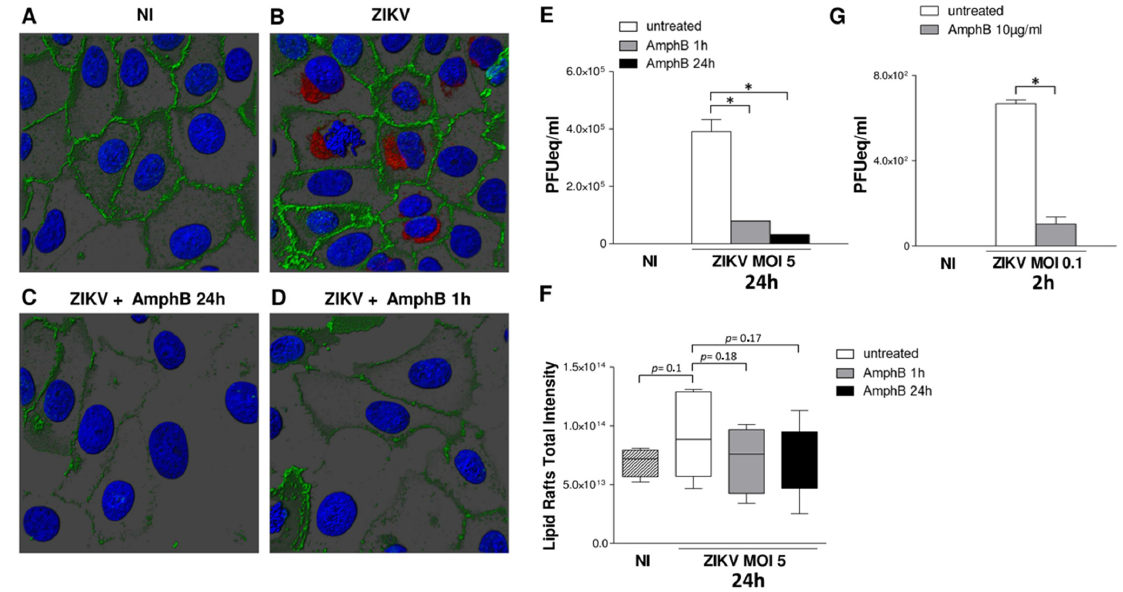
Figure 2. ZIKV exploits lipid rafts to enter and infect Vero cells. Vero cells were adsorbed with ZIKV at MOI 5 for 1 h at 37 °C in medium +/ − AmphB (10 µg/mL). Unbound virus was removed, and infected cells were cultured in fresh medium +/ − AmphB for 24 h or the drug was added only during 1 h of virus adsorption. At 24 h post-infection, cells were stained with the lipid raft marker CTB (green), fixed and stained with anti-pan-flavivirus antibody (ZIKV) followed by donkey anti-mouse Alexa Fluor 594 antibody (red). Nuclei were stained with DAPI (blue). 3D images were visualized and analysed by Imaris v8.1.2 software. NI: non-infected. ( A , B ) As compared to NI cells, ZIKV infection induced a lipid raft reorganization on cell surface. ( C ) Treatment with AmphB for 24 h disrupted lipid raft architecture and inhibited cell infection. ( D ) Treatment with AmphB only along 1 h of ZIKV adsorption disrupted lipid raft architecture and impaired the first steps of viral entry. Images are shown from one representative experiment out of three. ( E ) Viral titre was determined by qRT-PCR and expressed as PFU equivalents/mL (PFUeq/mL). Both drug treatments